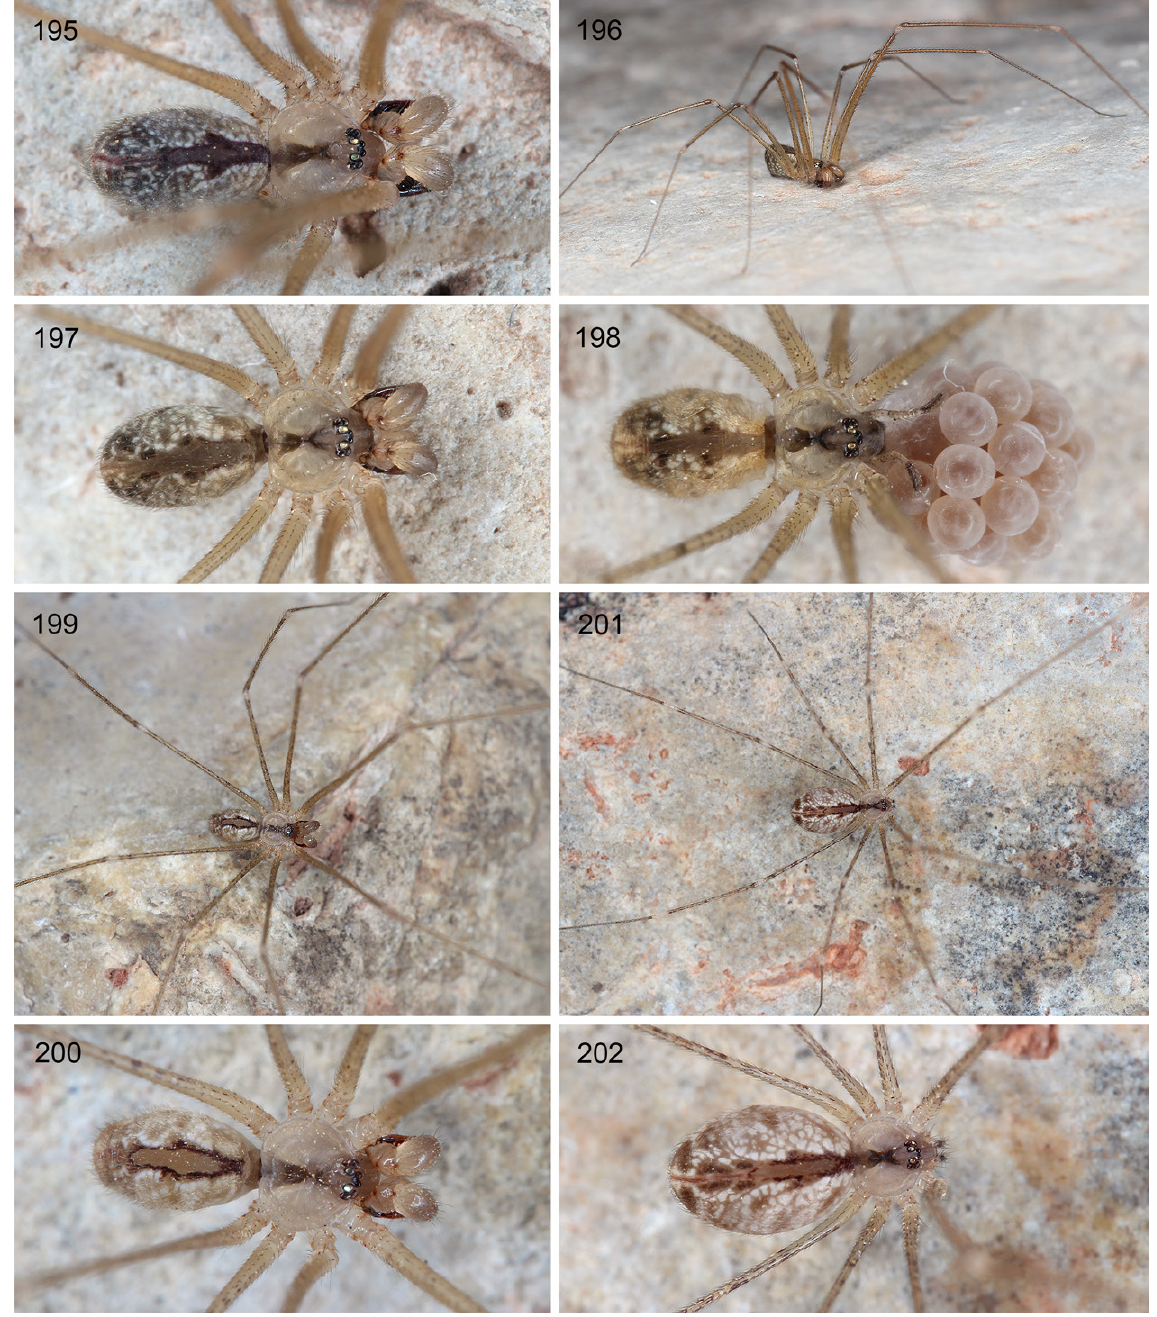
Figs 195–202. Maghreba gen. nov., live specimens. 195 . M. saghro gen. et sp. nov., male from Morocco, between Irherm and Tiferki. 196–198 . M. stifadma gen. et sp. nov., male and female from Morocco, Setti-Fatma. 199–202 . M. nkob gen. et sp. nov., male and female from Morocco, E of